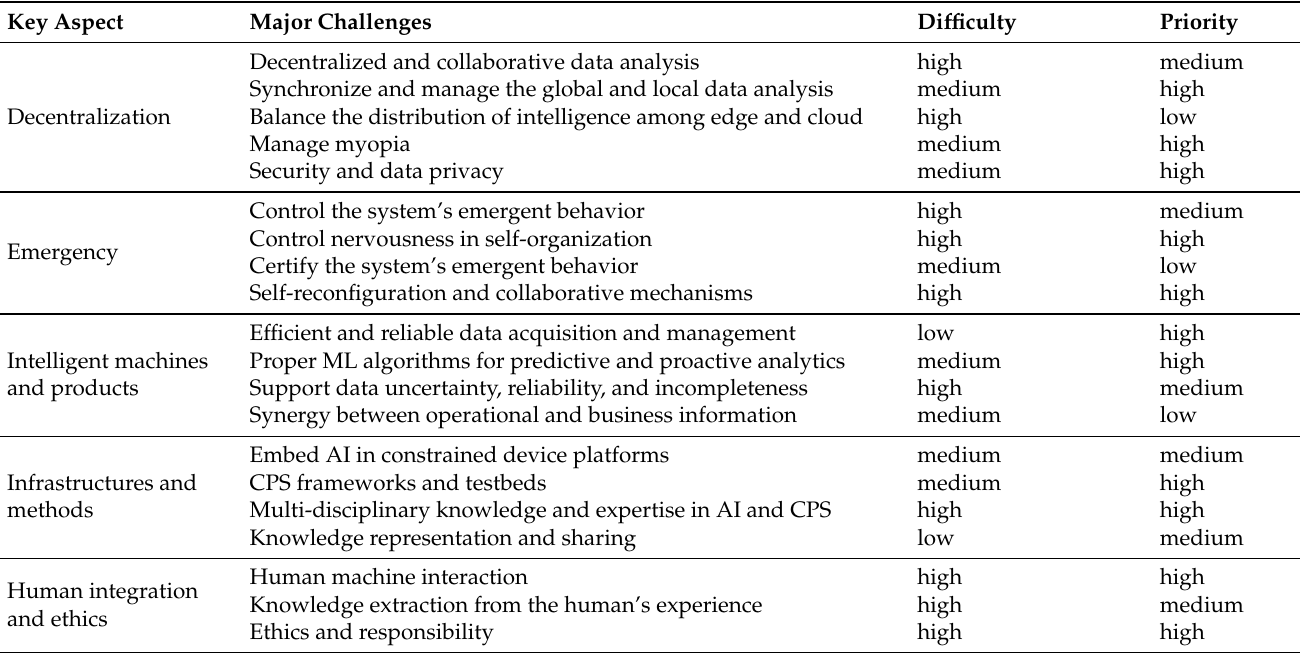
Table 3. Challenges and research opportunities for implementing collective intelligence in indus- trial